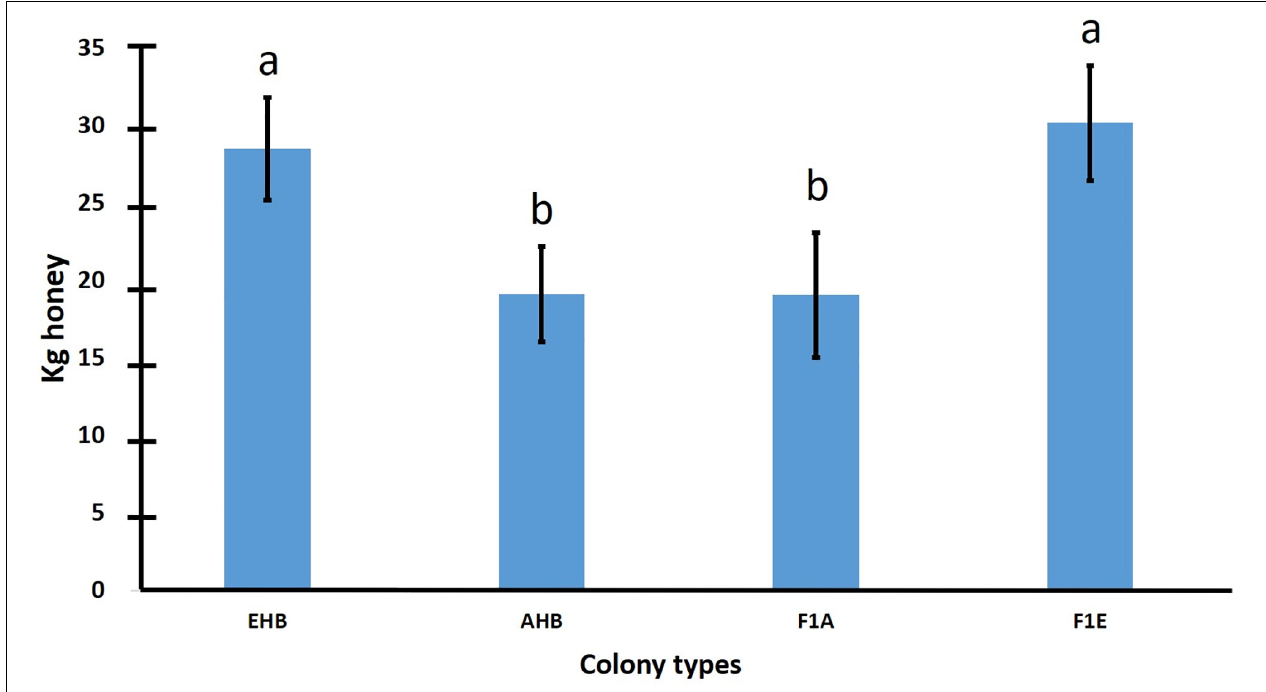
FIGURE 2 | Mean ( ± SE) honey yield per hive for 282 honey bee colonies of European, Africanized and hybrid genotypes (data from Guzman-Novoa and Uribe-Rubio, 2004).